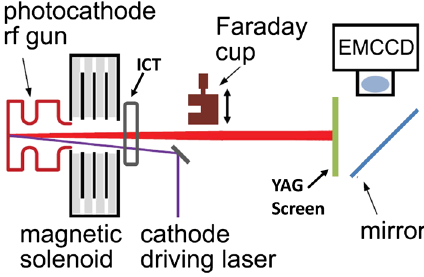
FIG. 3. Thermal emittance measurement setup.